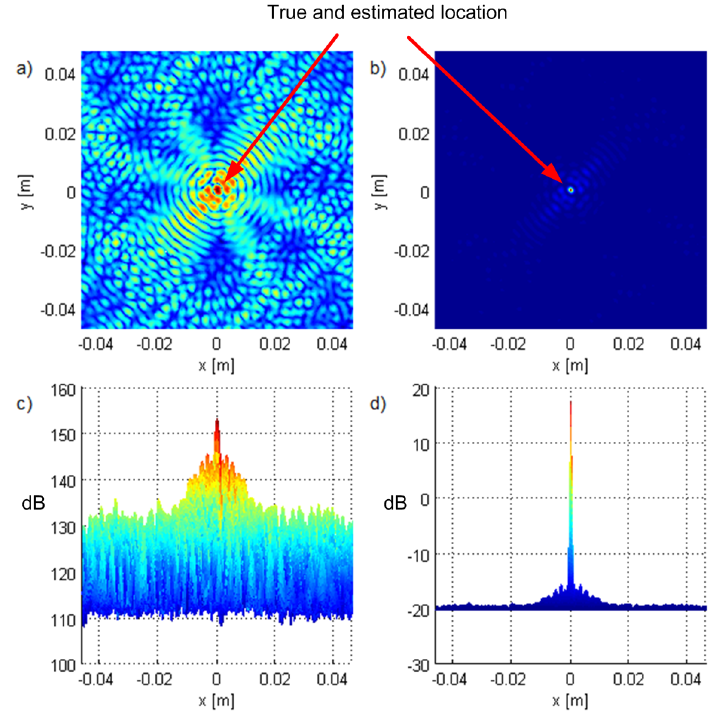
Figure 14. One-user LoS setting: top views of the criterion functions for G 90 and T 1 for ( a ) ML-US, ( b ) SCM-MUSIC, and the corresponding side views in ( c , d ) with the magnitude in